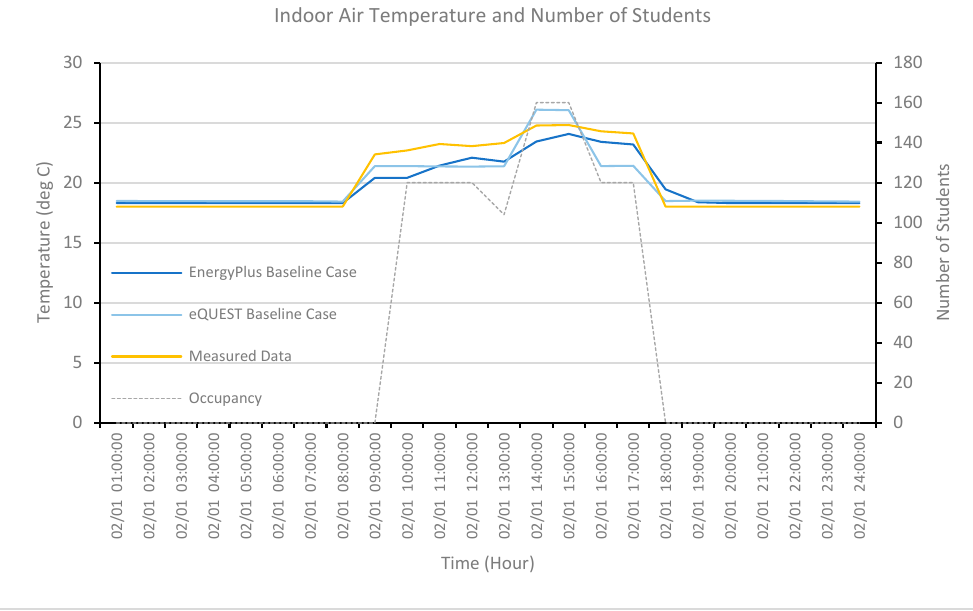
Figure 6. Temperature throughout a week, referencing occupants count.